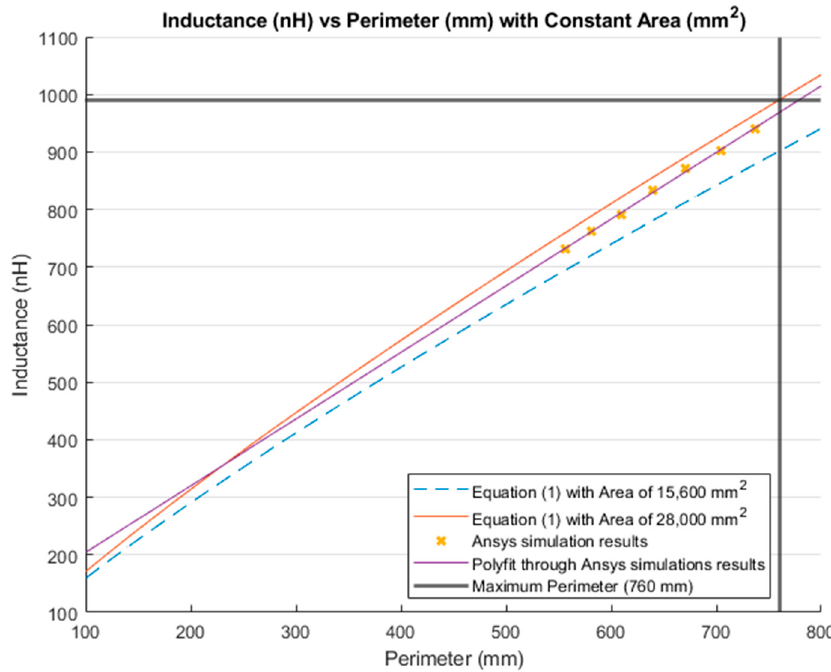
Figure 14. Comparison between the theoretical inductance calculations using Equation (1) with a constant area (mm 2 ) and simulations results.